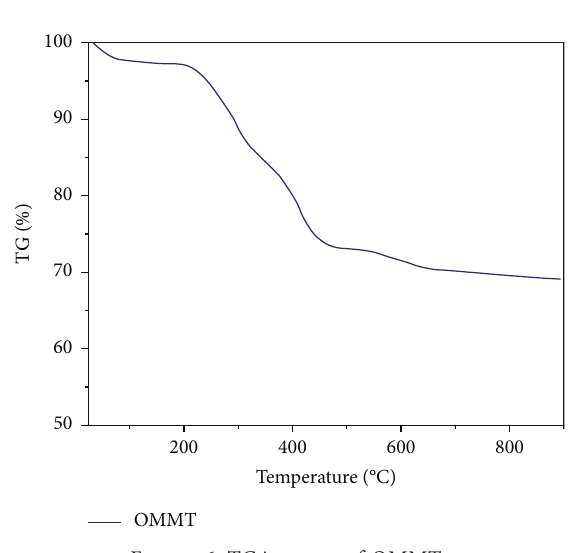
Figure 6: TGA curves of